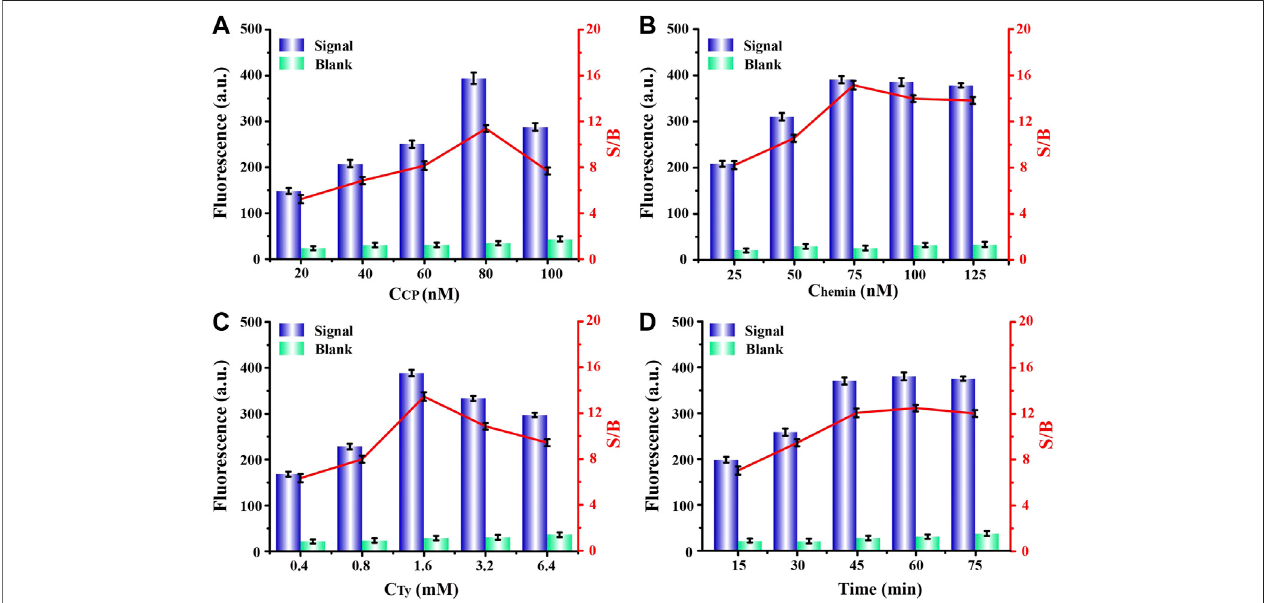
FIGURE 3 | Optimizations of experimental concentrations of (A) capture probe, (B) hemin, (C) tyramine, and (D) required reaction time for capture probe and exosomes, respectively.